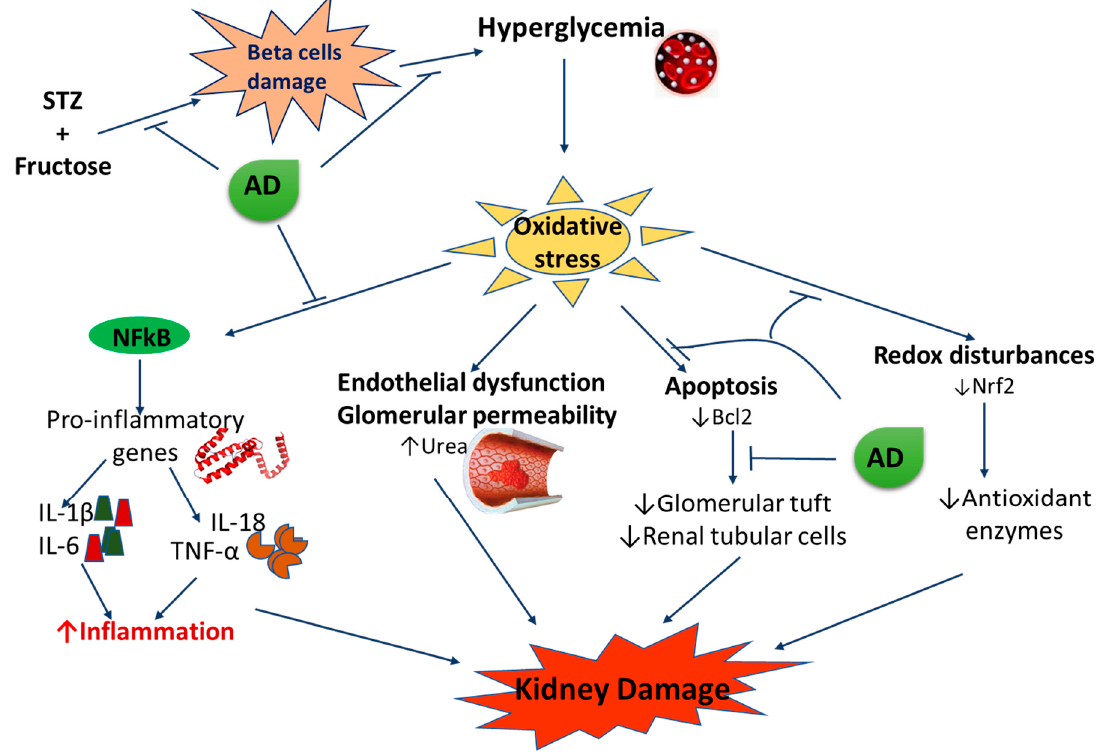
Figure 10. Proposed mechanisms by which AD ameliorates diabetic nephropathy and pancreatic damage. AD- Anchomanes difformis .